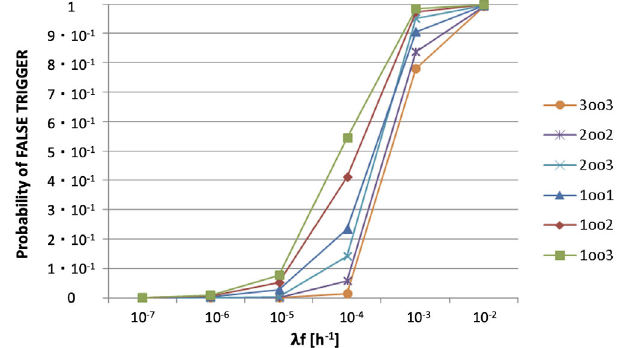
FIG. 13. Case I: Probability of demand missed against λ f between 1 × 10 − 7 h − 1 and 1 × 10 − 2 h − 1